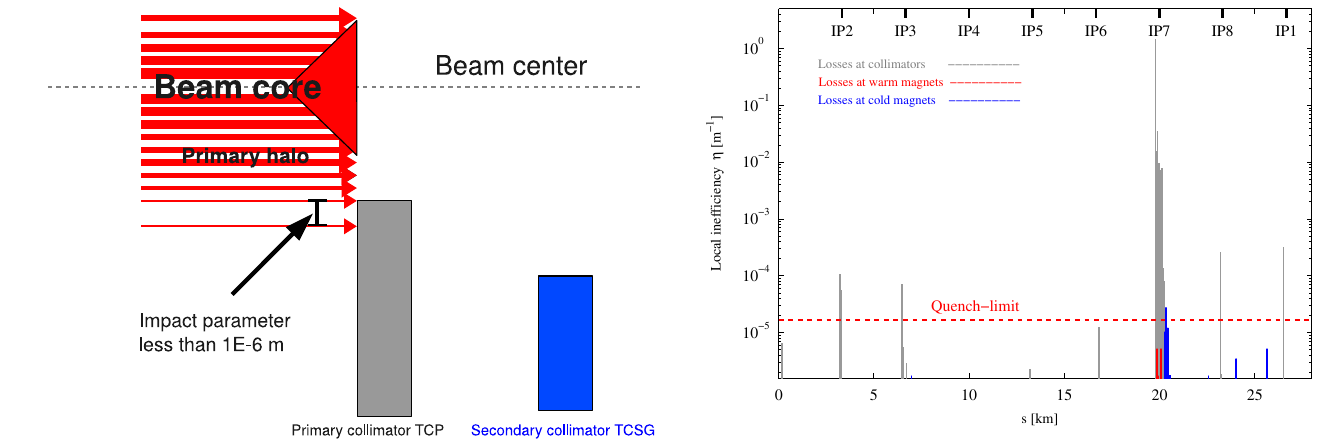
FIG. 25. (Color) Local loss map for nominal LHC (top energy, 0 : 55 m ), with one global crab cavity and horizontal (cid:5) (cid:3) IP1 ; 5 ¼ beam halo (beam halo generated at z ¼ 1 (cid:3) z ). A beam lifetime of 0.2 h is assumed to define the quench limit (red dashed line). This loss map is almost indistinguishable from the case without crab cavity.